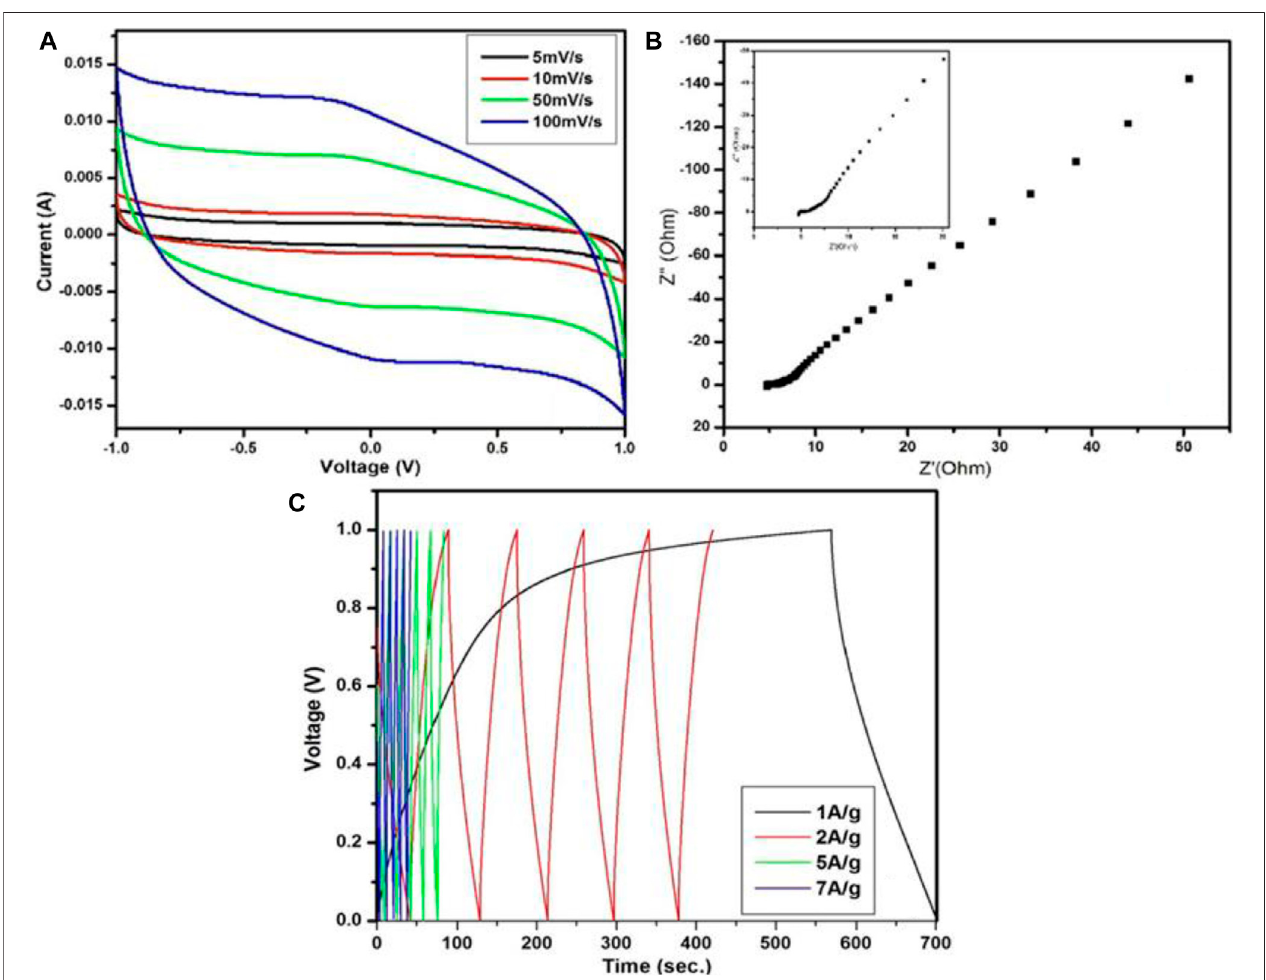
FIGURE 16 | (A) Cyclic Voltammetry (CV) curve (B) Nyquist plot (C) GCD curve of the graphene sheets based cell in 1 M H 3 PO 4 electrolyte (Pandey et al., 2021).